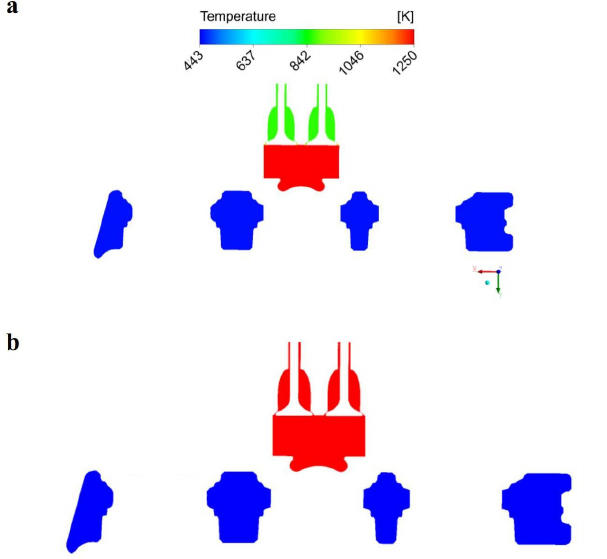
Figure 7. Contour plot of initial temperature ( a ) and gaseous mixture mass fraction ( b ) along a plane through the cylinders axes.